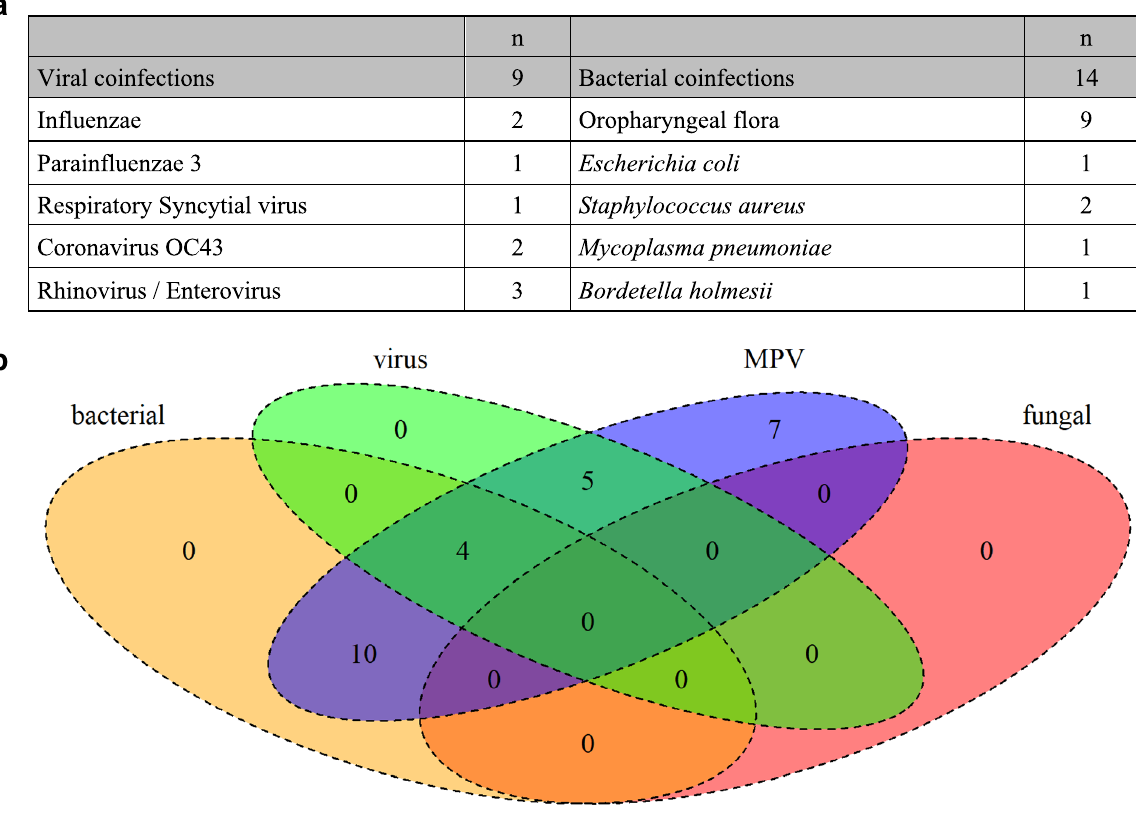
Fig. 2 Coinfections in the hMPV-infection cohort. a Bacterial and viral identifications. b Venn diagram presenting the distribution of coinfections. MPV: human